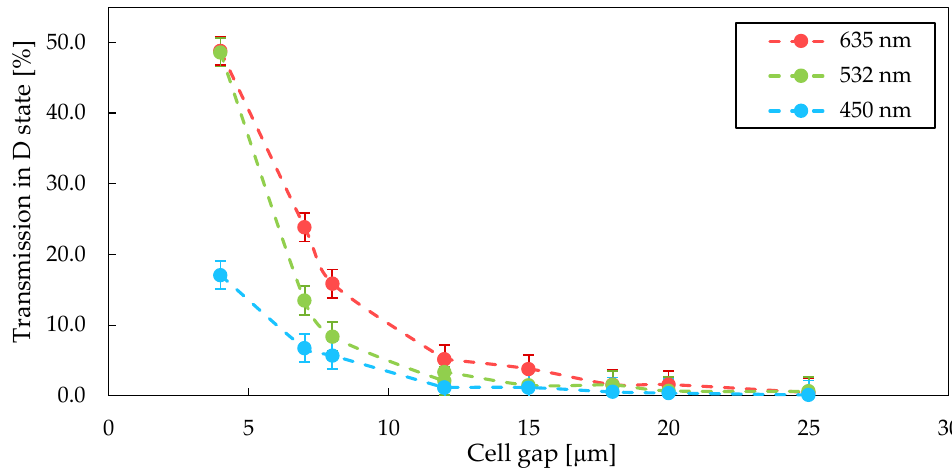
Figure 8. Light transmission in the diffuse (D) state, depending on cell gap and wavelength.